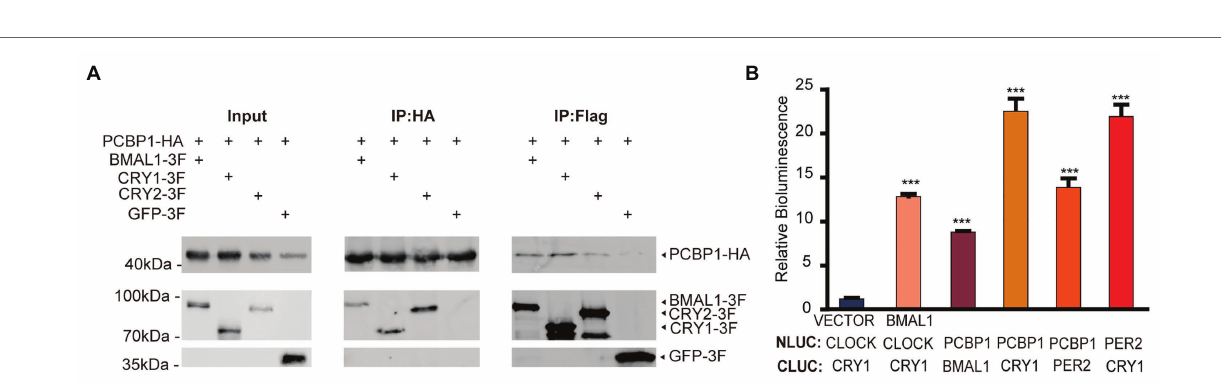
FIGURE 3 | PCBP1 interacts with core clock molecules. (A) Co-immunoprecipitation assay shows the interaction between PCBP1 and core clock molecules (CYR1, CRY2, and BMAL1). (B) Luciferase complementation assay validates the interaction between PCBP1 and core clock molecules (CRY1, PER2, and BMAL1). All data are presented as the mean ± SEM from three independent experiments. Statistical significance was determined using one-way ANOVA ( n = 3, *** p <